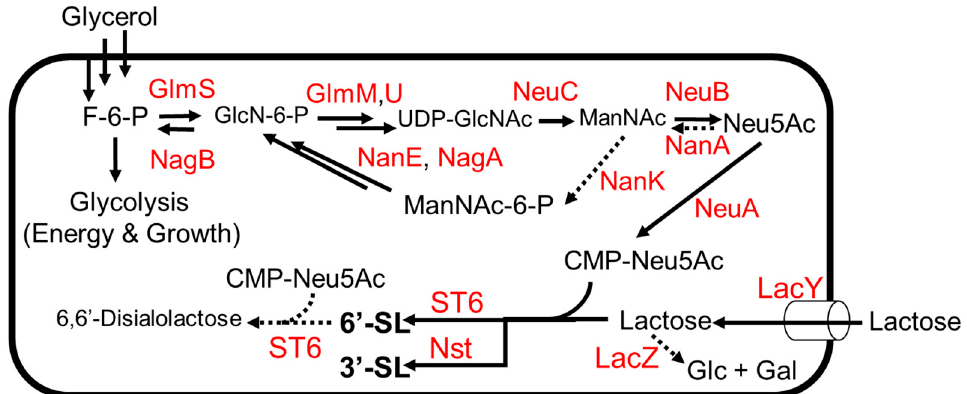
Figure 5. The 6 ′ -SL and 3 ′ -SL production from glycerol and lactose . Dotted arrows indicate competing pathways. Abbreviations: GlmS, L-glutamine—D-fructose-6-phosphate pathways. Abbreviations: GlmS, L-glutamine—D-fructose-6-phosphate aminotransferase; GlmM, aminotransferase; GlmM, phosphoglucosamine mutase; GlmU, fused N-acetylglucosamine-1- phosphoglucosamine mutase; GlmU, fused N-acetylglucosamine-1-phosphate uridyltransferase phosphate uridyltransferase and glucosamine-1-phosphate acetyltransferase; LacZ, β - and glucosamine-1-phosphate acetyltransferase; LacZ, β -galactosidase; LacY, lactose permease; galactosidase; LacY, lactose permease; NagB, glucosamine-6-phosphate deaminase; NanE, N - NagB, glucosamine-6-phosphate deaminase; NanE, N -acetylmannosamine-6-phosphate 2-epimerase; acetylmannosamine-6-phosphate 2-epimerase; NagA, N -acetylglucosamine-6-phosphate NagA, N -acetylglucosamine-6-phosphate deacetylase; NanK, N -acetylmannosamine kinase; NeuC, deacetylase; NanK, N -acetylmannosamine kinase; NeuC, GlcNAc-6-phosphate 2 epimerase; NeuB, GlcNAc-6-phosphate 2 epimerase; NeuB, sialic acid synthase; NeuA, CMP-Neu5Ac synthetase; NanA, sialic acid synthase; NeuA, CMP-Neu5Ac synthetase; NanA, N -acetylneuraminate lyase; ST6, N -acetylneuraminate lyase; ST6, ( α 2,6)-Sialyltransferase; Nst, ( α 2,3) NeuAc ( α 2 , 6)-Sialyltransferase; Nst, ( α 2,3) NeuAc transferase.